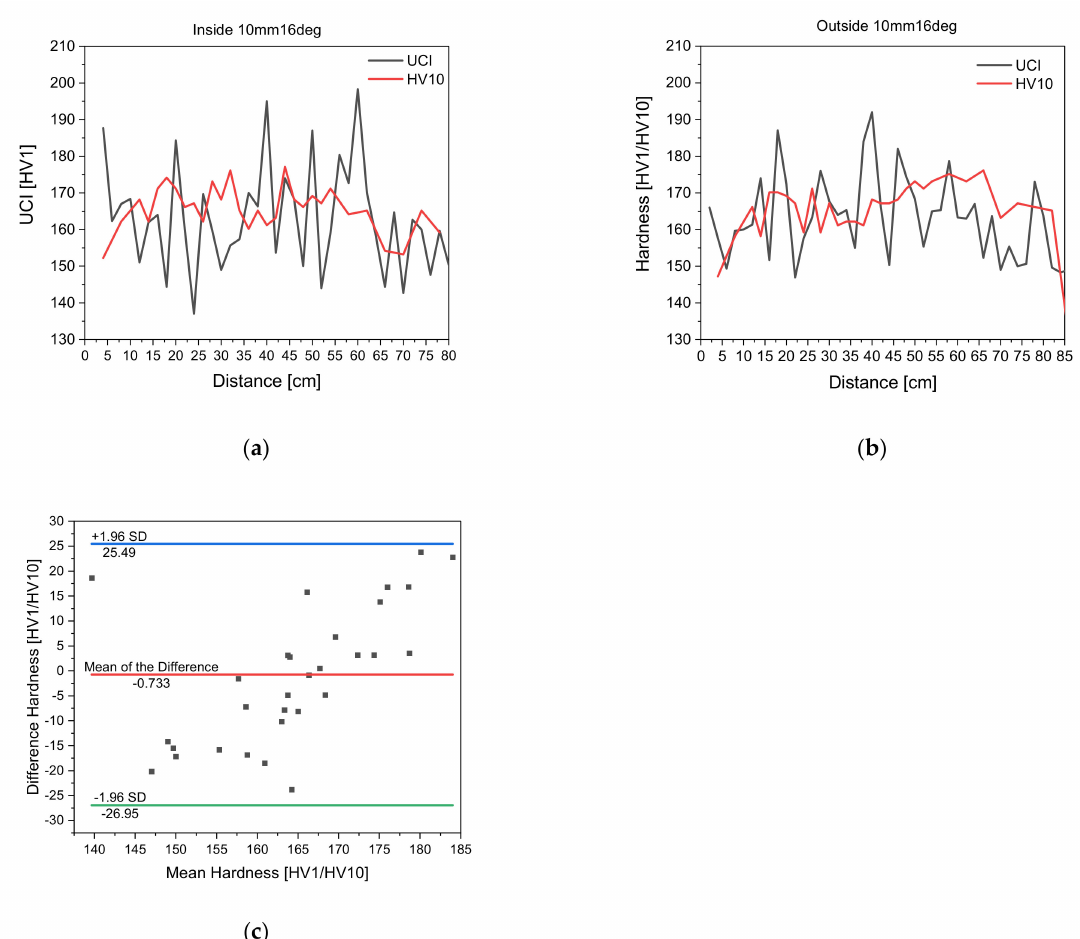
Figure 4. UCI hardness plots vs. HV 10 hardness plots for measurement suitability analysis; ( a ) UCI hardness vs. HV 10 measurements of non-tangentially bent tube with bending strategy 10 mm 16 deg on the inside; ( b ) UCI hardness vs. HV 10 measurements of non-tangentially bent tube with bending strategy 10 mm 16 deg on the outside; ( c ) Bland–Altman plot for concordance analysis between UCI hardness and HV 10 hardness measurements taken on 10 mm 16 deg bent